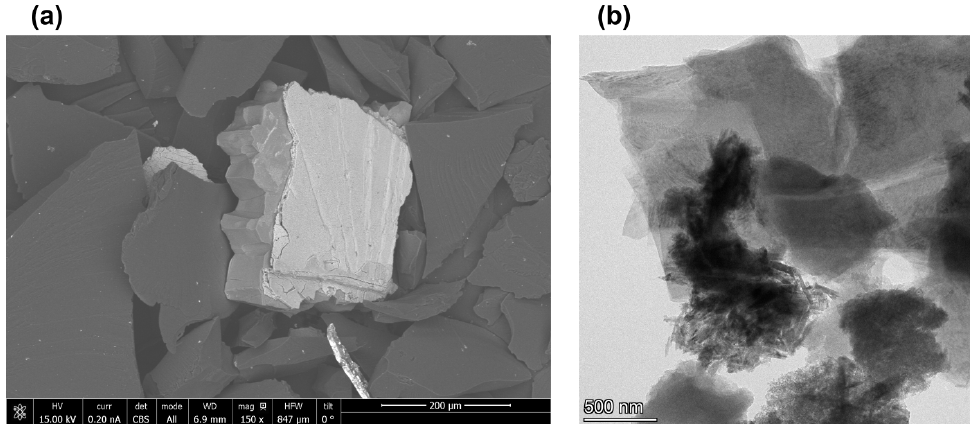
Figure 2. ( a ) Scanning electron microscopy (SEM) image of shungite particles before dispergation treatment and ( b ) transmission electron microscopy (TEM) image of graphene layers obtained from shungite.